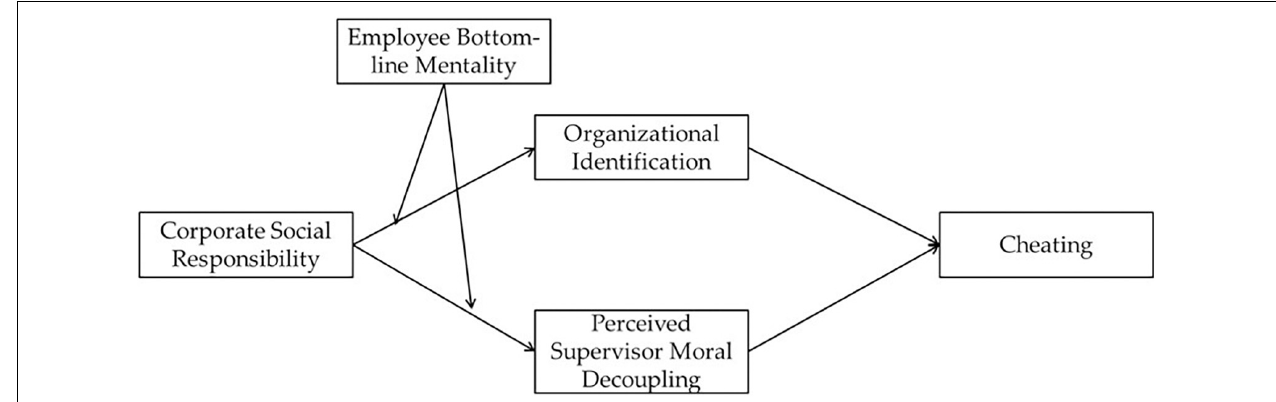
FIGURE 1 | Conceptual